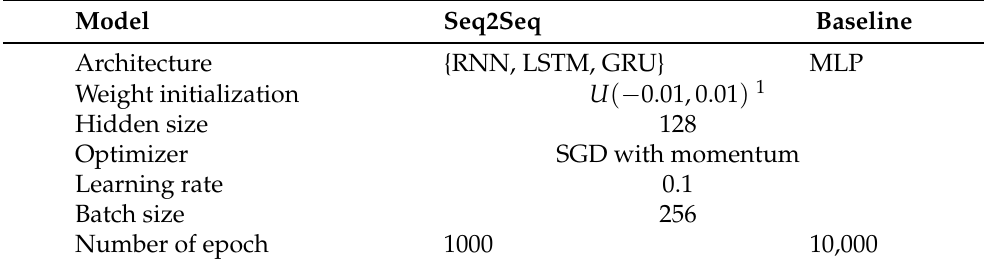
Table 2. Hyper-parameter settings.